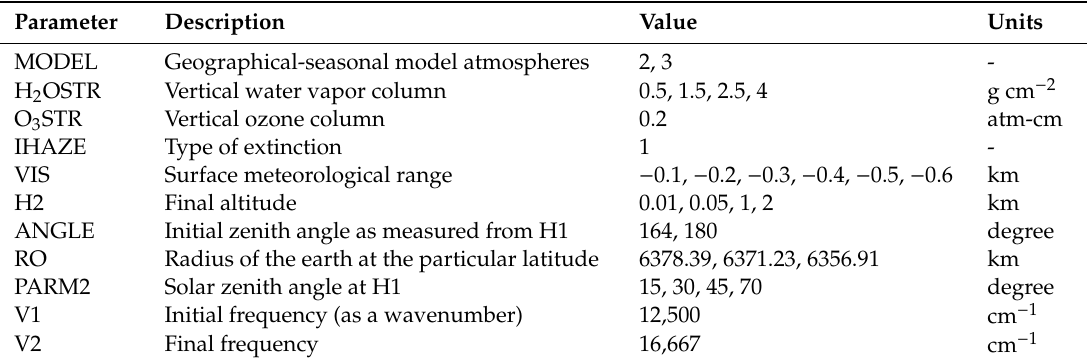
Table 3. Main input parameters for the MODerate resolution atmospheric TRANsmission (MODTRAN 5) model simulations.